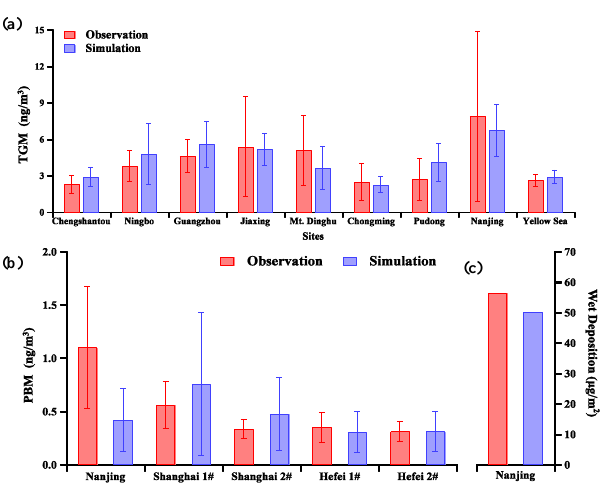
Figure 3. Comparison between simulated results and measurements in sites for (a) TGM concentration, (b) PBM concentration and (c) wet deposition.